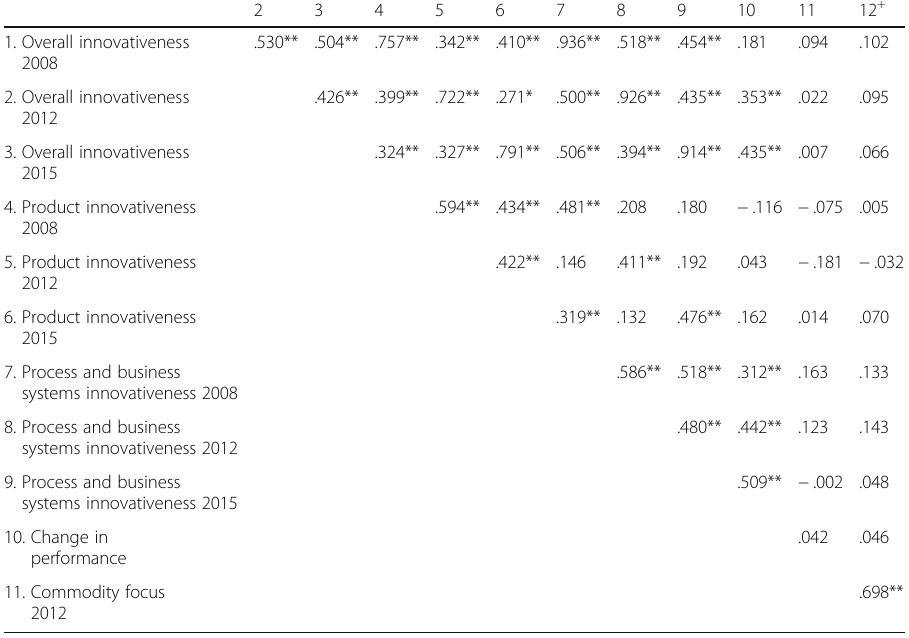
Table 6 Pearson ’ s correlation matrix for key study